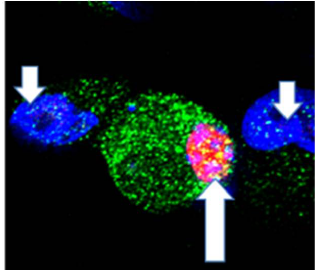
Figure 3. Expression of AdipoR1 and PCNA in Human ARPE-19 cells. Human ARPE-19 cells were fixed and double immunocytochemical staining for AdipoR1 (green color) and PCNA (red color) was performed. DAPI (blue color) was used for nuclei counterstaining. Laser confocal microscopy demonstrated increased levels of AdipoR1 in PCNA-positive cells in pink (indicated by upward arrow) compared to PCNA-negative in blue (indicated by downward arrow) cells. Magnification of objective is 40x.